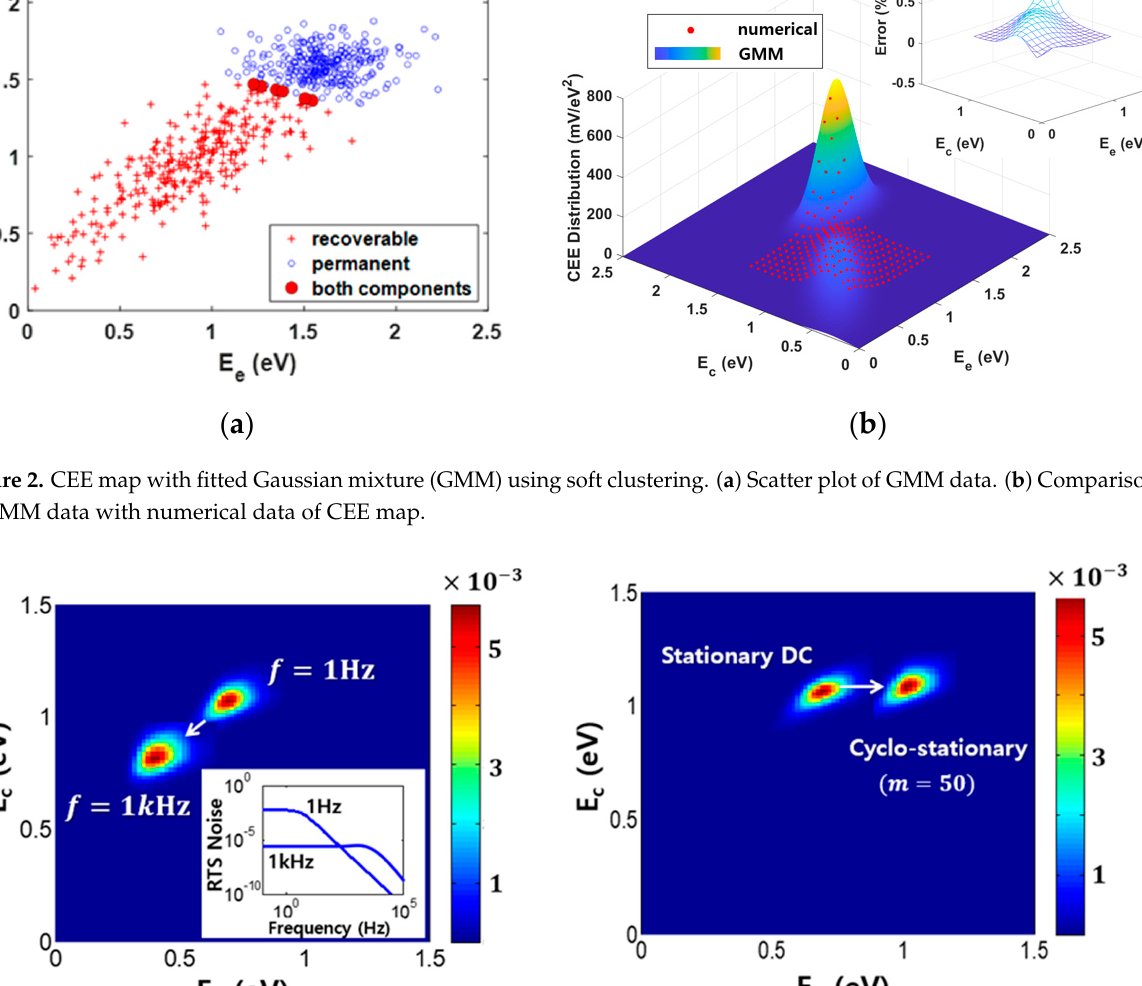
Figure 3. Integrand of S N ( ω ) for the recoverable component. ( a ) f = 1 Hz and f = 1 kHz under stationary condition for V gs = − 2 V. ( b ) f = 1 Hz and m = 50 under cyclo-stationary condition for V gs = − 2